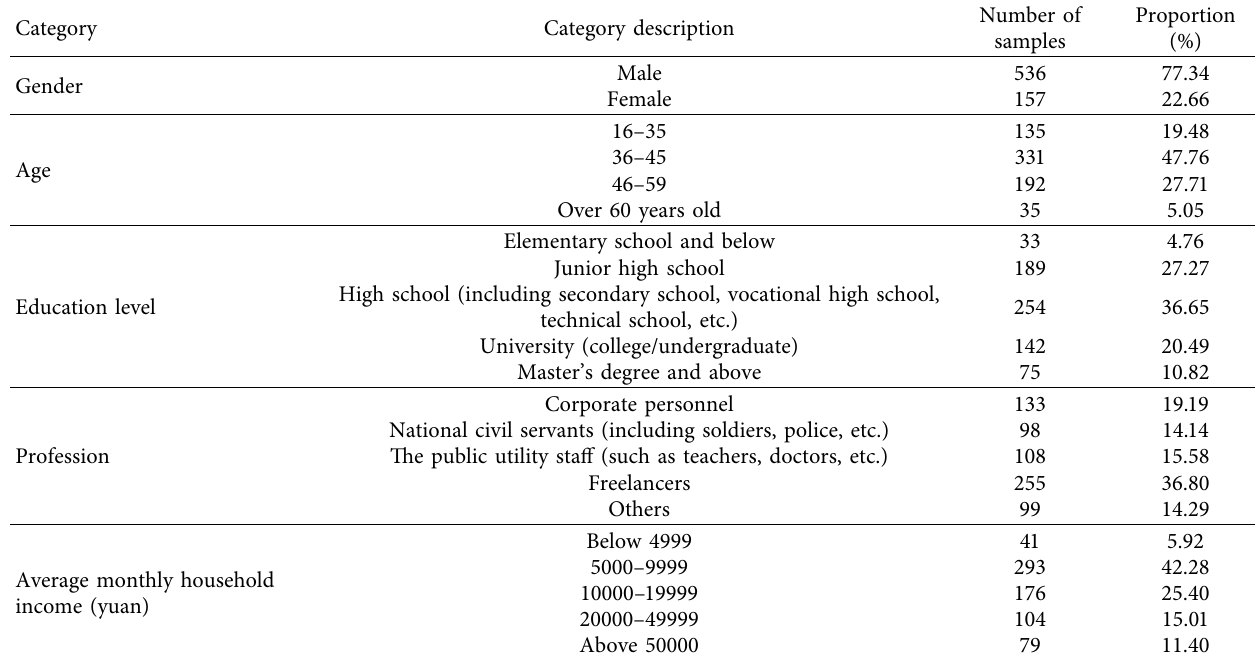
Table 8: Sample demographic characteristics information.